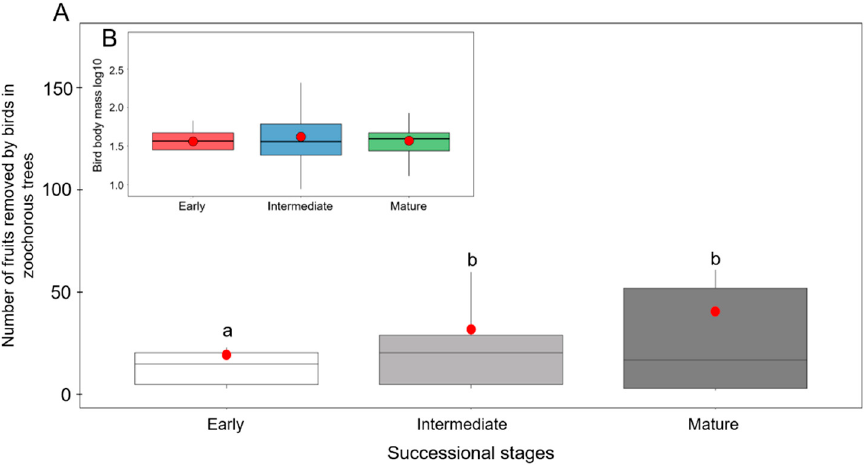
Figure 2. ( A ) Fruit removal in zoochorous trees and ( B ) fruit-eating bird body mass along a succes- sional gradient of TDF in southern Mexico. The red point in each boxplot represents the average